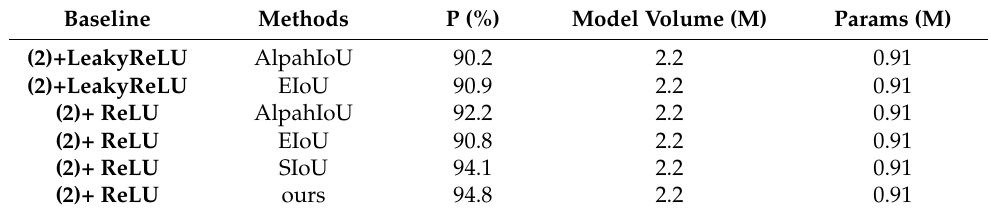
Table 11. The ablation study of IoU on the SSDD